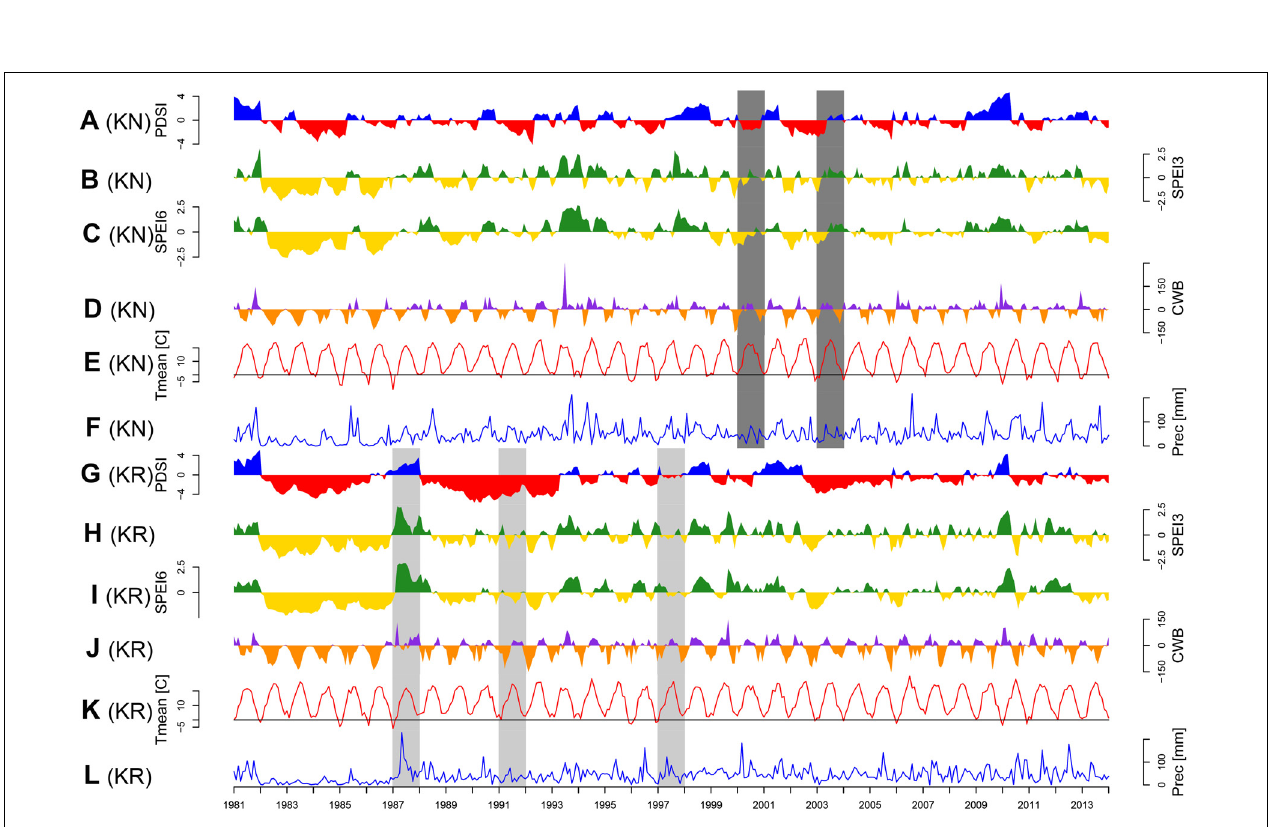
FIGURE 3 | Temporal variations of main climatic parameters: Palmer Drought Severity Index (PDSI; A and G ), standardized precipitation evapotranspiration index integrated over three (SPEI3; B and H ) and six months period (SPEI6; C and I ), climatic water balance (CWB; D and J ), monthly mean temperature (Tmean; E and K ) and monthly precipitation sum (Prec; F and L ). Panels A–F : Knyszyn site, panels F–K : Kórnik site. Common pointer years (CPY, more than five provenances) are indicated by light gray (positive) and dark gray (negative) poligons.